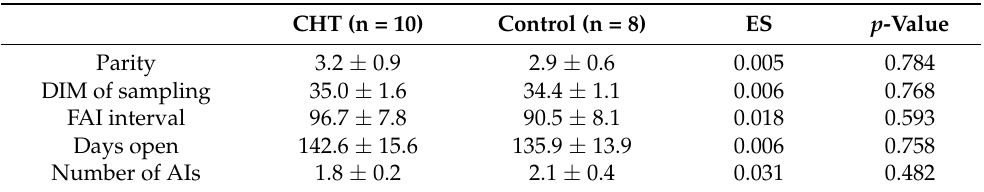
Table 3. Reproductive performance of cows whose uterus recovered normally at the time of the fresh cow check with or without the administration of a chitosan